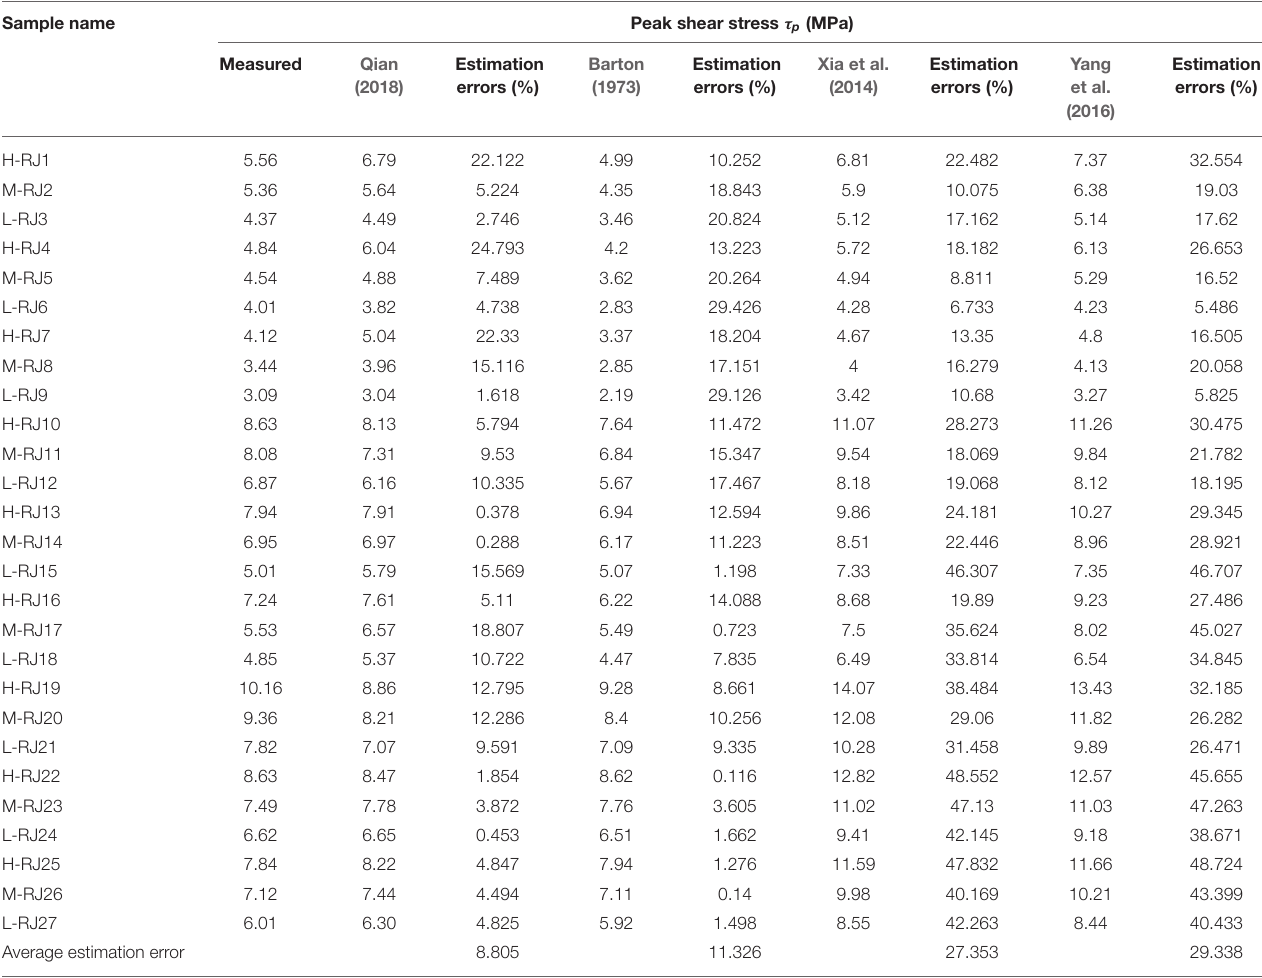
TABLE 2 | Comparison of the experimental peak shear stress and the predicted peak shear stress of different